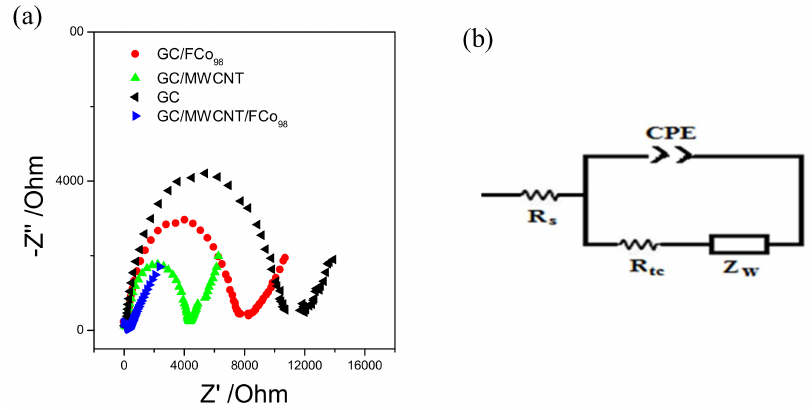
Figure 4. ( a ) Complex plane spectra obtained for the modified electrode with GC (–), GC/ FCo 98 (–), GC/MWCNT (–) and GC/MWCNT/FCo 98 (–) using a 100 kHz frequency band at 0.1 Hz, 10 mV sine wave applied at the E pa = 0.4 V vs. Ag/AgCl. The lines that go beyond the identifiers are the simulation results with software that employ the modified Randles circuit. ( b ) An equivalent circuit model was used to analyze the data, together with the complex plane graphs obtained from the EIS.